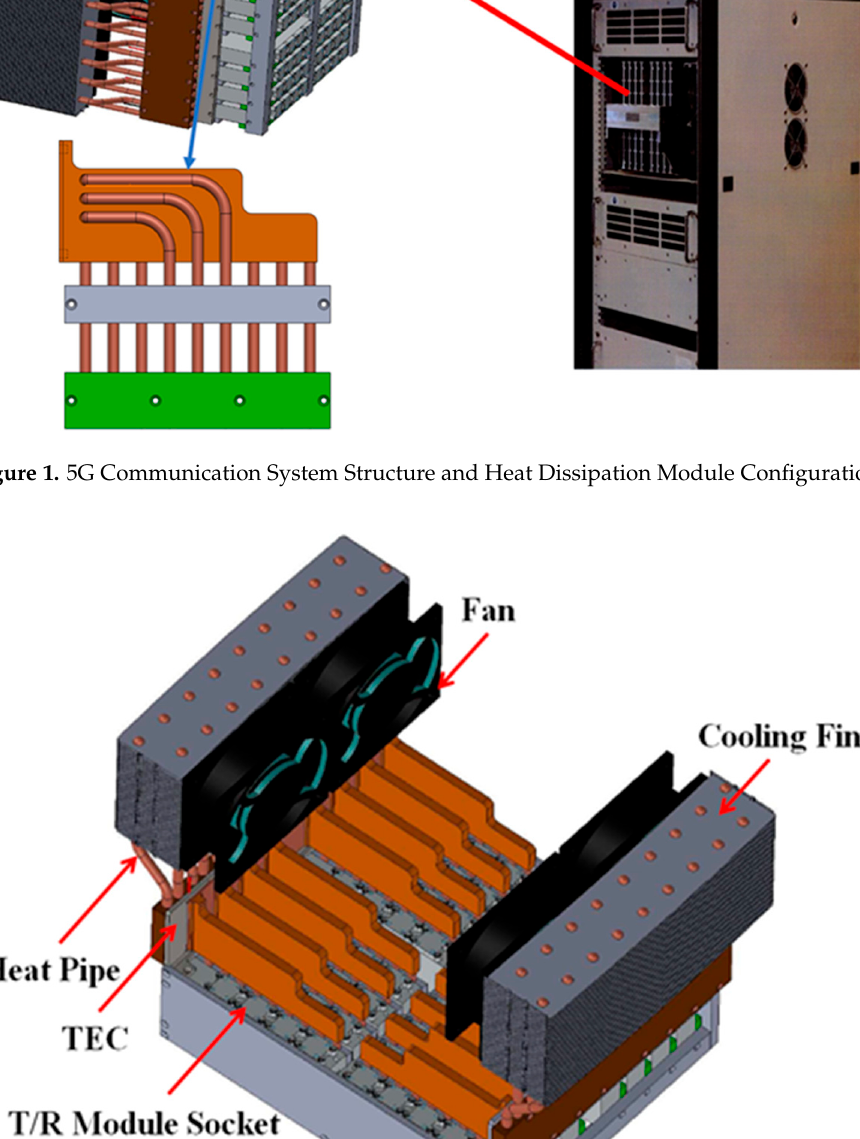
Figure 2. Integrated T/R Module and Heat Dissipation Module.